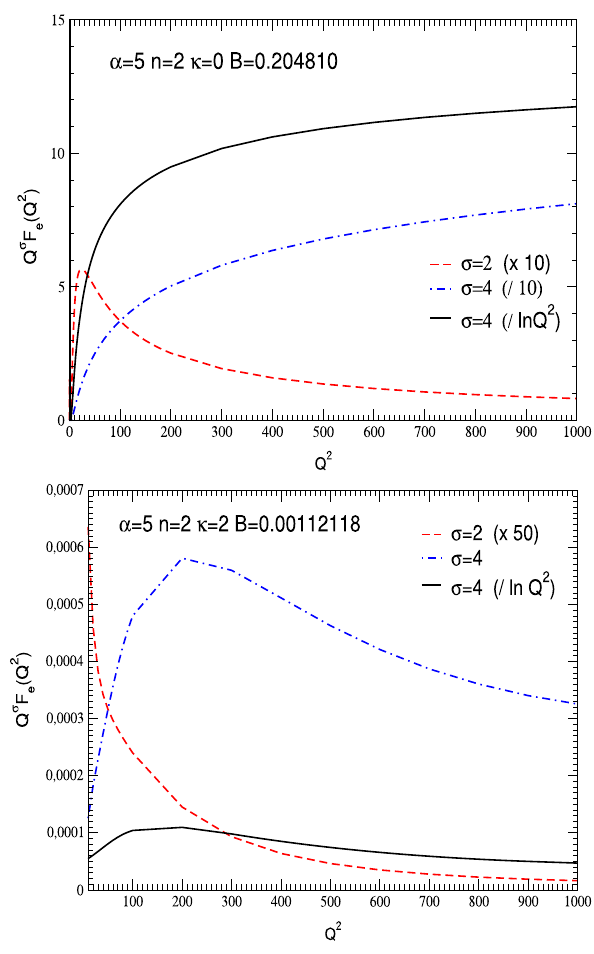
Fig. 16 Asymptotic behaviour of the elastic form factors of n = 2 states of Table 1 (solid lines): No. 2 (normal) on top and No. 4 (abnormal) at bottom